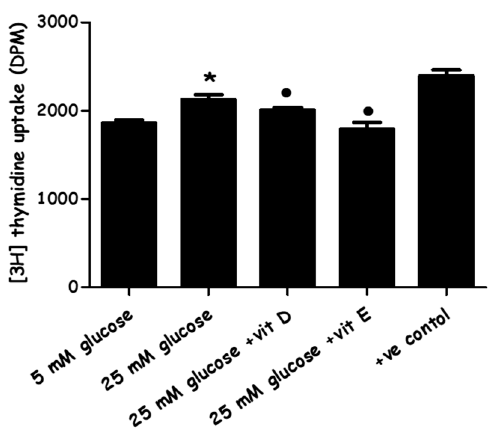
Figure 4. The effect of vitamin D and vitamin E on high glucose-induced [ 3 H] thymidine uptake by PASMCs. Quiesced cells were cultured with normal (five mM) and high glucose (25 mM) for 72 h. Vitamin D (80 ng/mL) and vitamin E (9 µg/mL) were added immediately along with high-glucose incubation. [ 3 H]-thymidine incorporation assay was performed for the evaluation of DNA synthesis (as an index of cell proliferation). Radioactive counts were measured in disintegrations per minutes (DPMs) ± SEM. * p < 0.05 vs. cells cultured in normal glucose (five mM) media. • p < 0.05 vs. high glucose cultured cells ( n = 4). ANOVA one way followed by Tukey’s comparison test were performed. (+ve) control: cells placed in culture of ordinary environment with no adjusted glucose and 10% bovine serum.